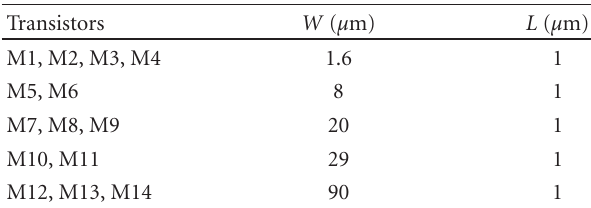
Table 1: Aspect ratios